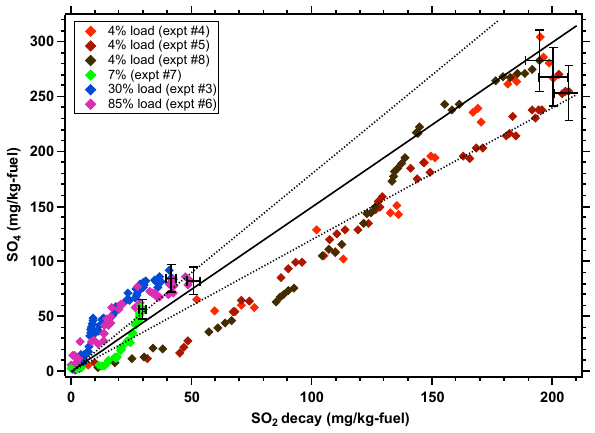
Fig. 6. Comparison of sulfate production inferred from the mea- sured SO 2 decay (x-axis) to that measured with the AMS. Perfect agreement is indicated by the solid line; the dashed lines indicate ±